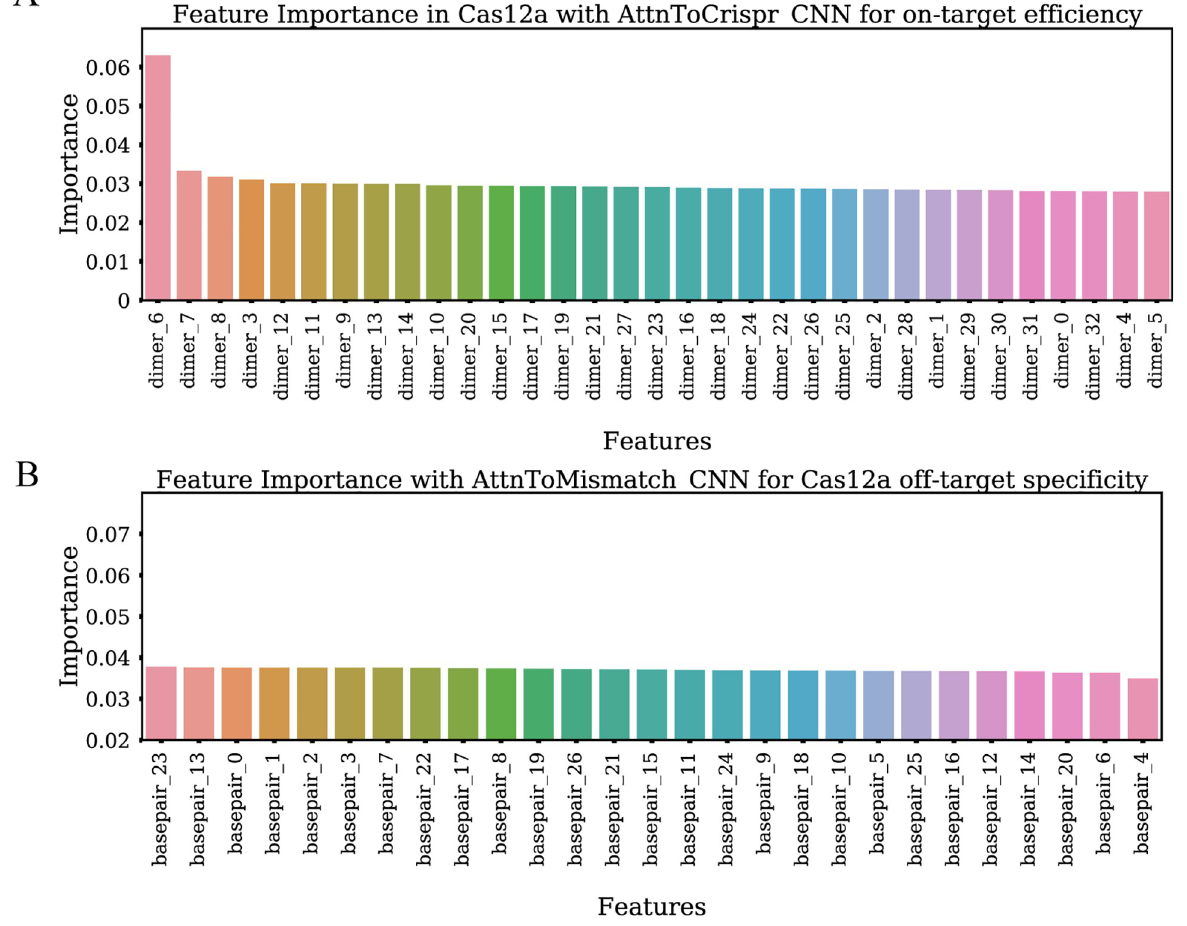
Fig 6. Feature importance study with input features perturbation method. A) The feature importance of AttnToCrispr_CNN on-target efficiency prediction model, which is trained with Crispr-Cas12a dataset. Each dimer is two contiguous nucleotide bases on a input sequence. B) The feature importance of AttnToMismatch_CNN off-target specificity prediction model, which is trained with Crispr-Cas12a dataset. Each dimer is a nucleotide base pair, with one from a sgRNA and its counterpart in the target DNA.